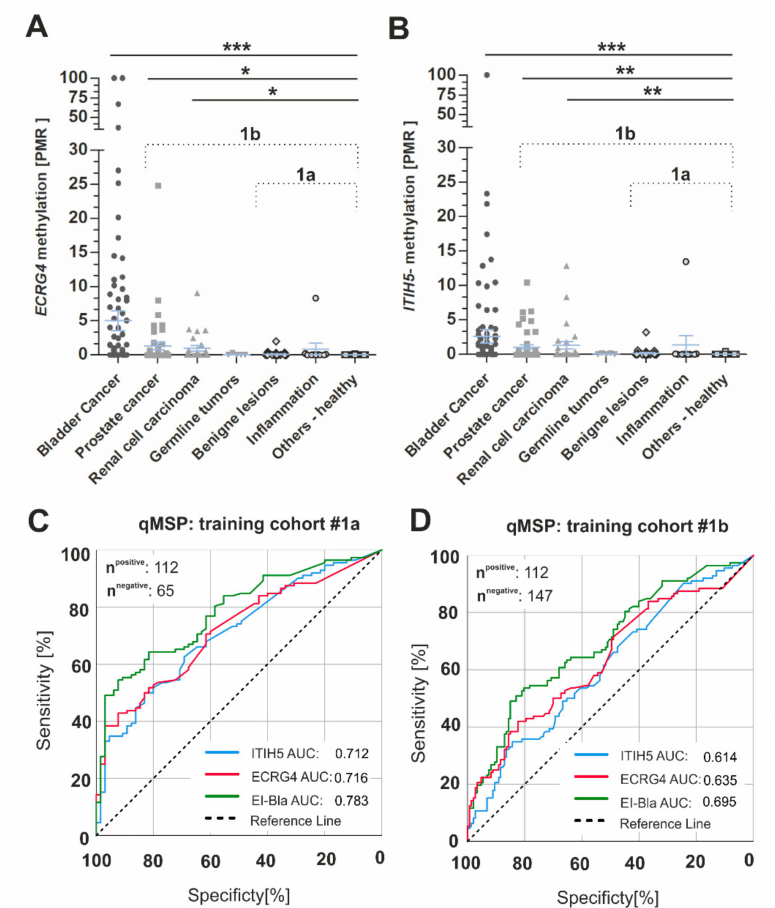
Figure 3. Performance of the ECRG4 and ITIH5 biomarker panel using qMSP technique and training cohort #1. ( A , B ) Scatterplots show the PMR methylation values for ECRG4 ( A ) and ITIH5 ( B ) in urine sediments of urological tumors, benign lesions, inflammatory diseases and healthy samples; *** p < 0.001, ** p < 0.01, * p < 0.05. 1a: training cohort excluding other urological malignancies 1b: training cohort including other urological malignancies. ( C , D ) ROC-curve analysis illustrating ECRG4 (red curve), ITIH5 (blue curve) and ECRG4 - ITIH5 (green curve) biomarker performance based on qMSP in cohort 1a (being and inflammatory controls ( C )) and cohort 1b (further urological cancer entities as controls ( D )), AUC : Area under the